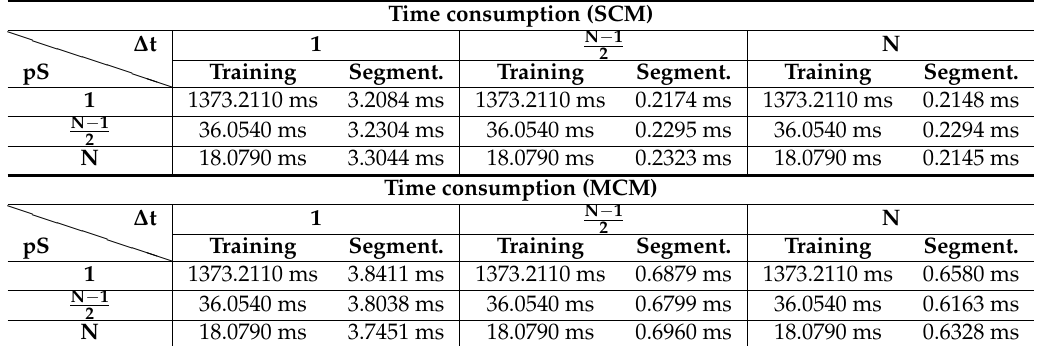
Table 8. Training and segmentation time consumption when using SCM and MCM.